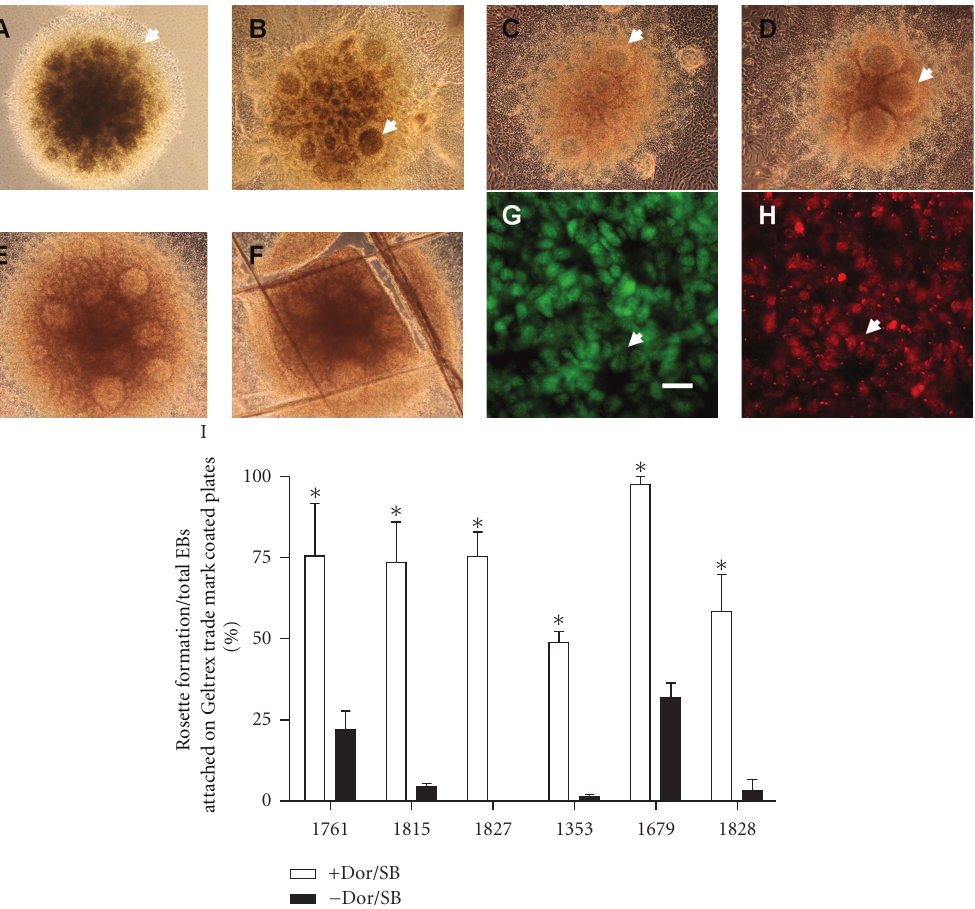
Figure 3: Representative images of neural rosettes at di ff erent stages (A–D). Neural rosettes after Dor/SB treatment at days 7–12, stage III of the di ff erentiation protocol (5x magnification). Arrows indicate boundary lines in the early and late stages of rosettes. (E) and (F) Manual dissection of rosettes using scalpel are illustrated before (E) and after (F) cutting. (G and H) Arrows indicate the positions of neural rosettes that were immunoreactive with Pax6 (green) (E) and Sox1 (red) (F). Scale bar represents 20 μ m. (i) There is a significant di ff erence in neural rosette formation in all control and PD-specific EBs treated with Dor/SM compared to those with no Dor/SB treatment during stage II ( ∗ P < 0 . 01). Data are presented as mean + standard error of the mean (SEM) compared to the controls ( n = 3, except 1679, n = 2). P value of each study was assessed by one-way ANOVA along with Newman-Keuls post- hoc analysis.